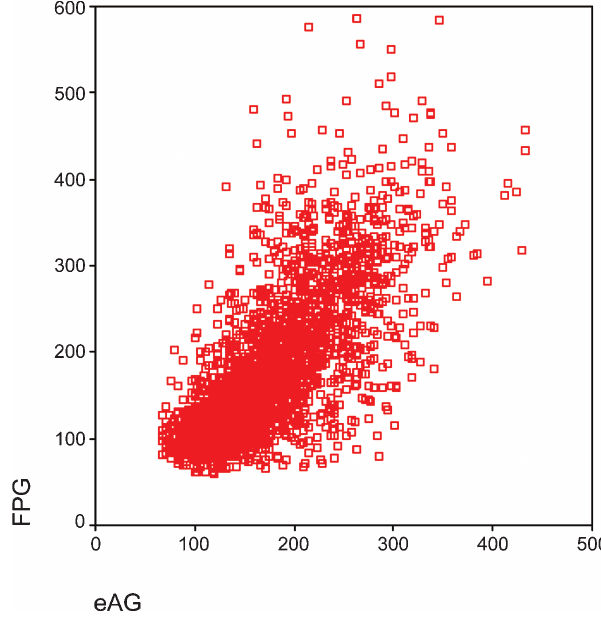
Figure 1 - Scatter-plot of FPG vs eAG in the